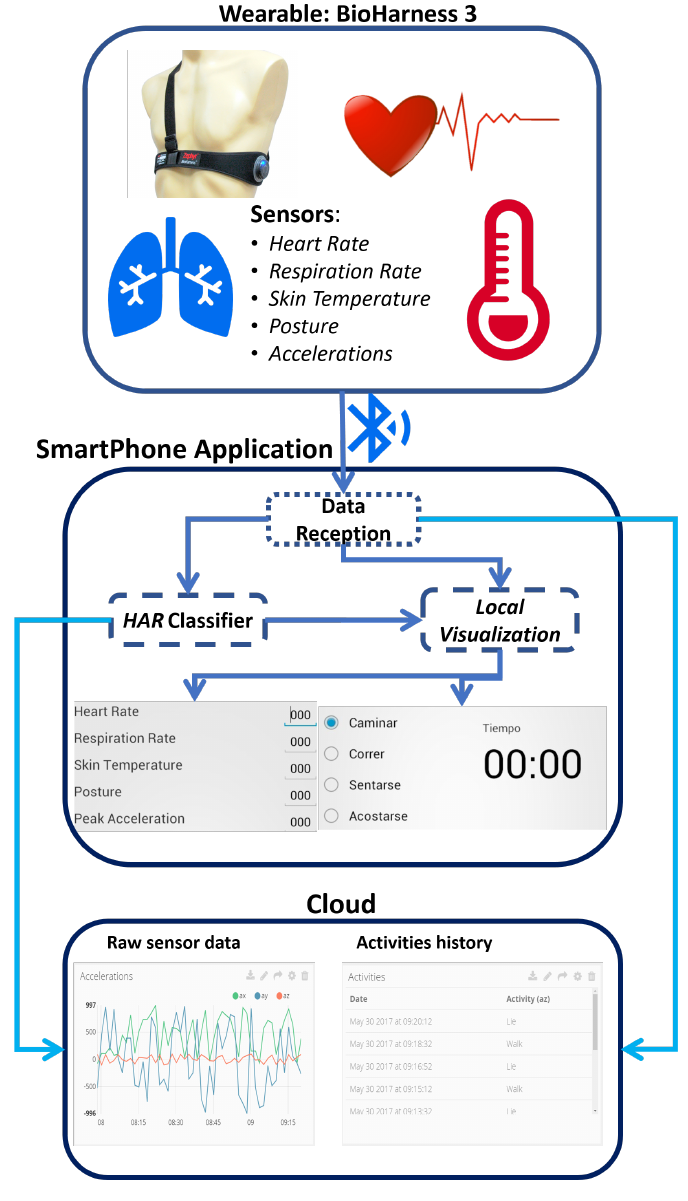
Figure 4. Solution